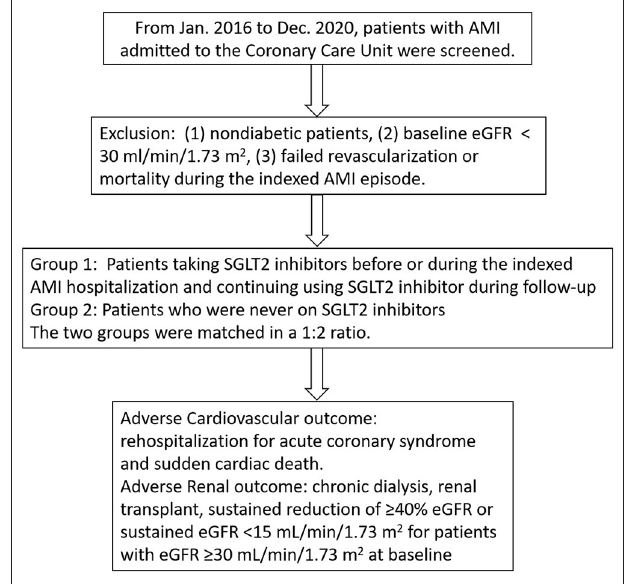
FIGURE 1 | The flow diagram of this